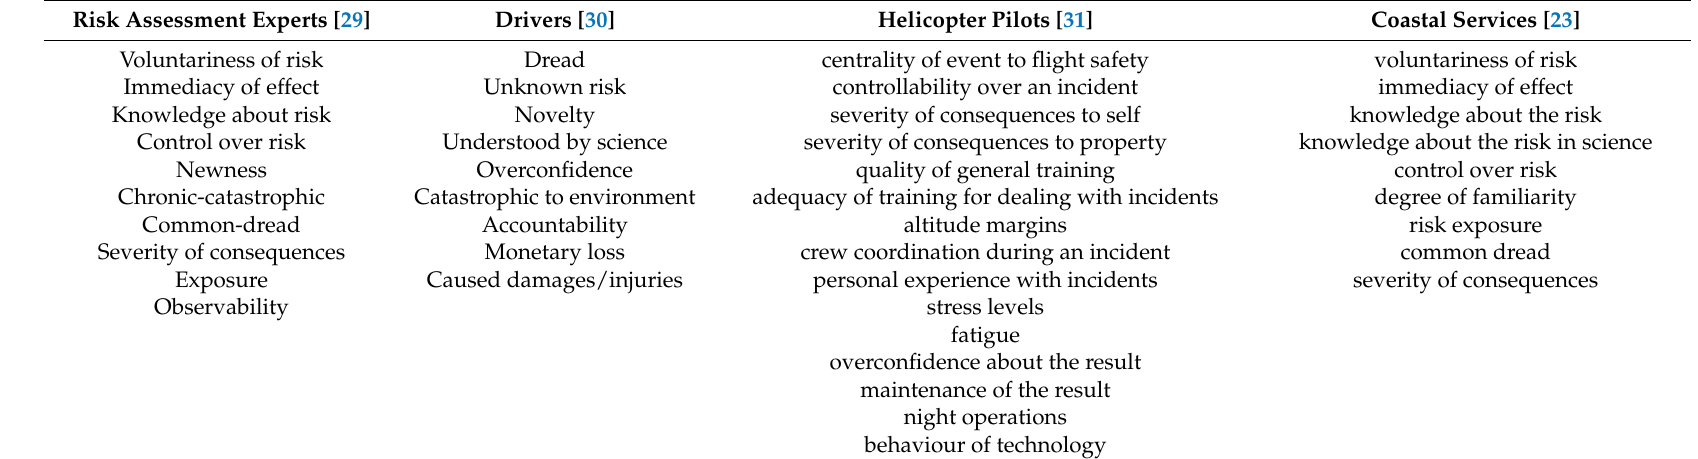
Table A1. Risk perception factors.